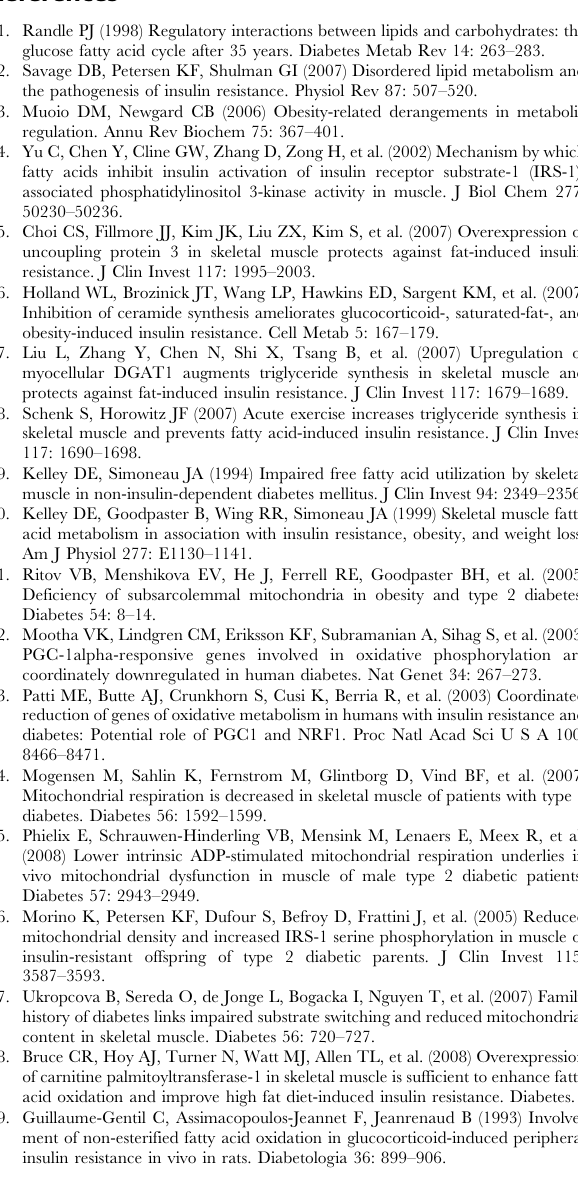
Table S2 Complete listing of metabolites detected in each condition according to criteria described in